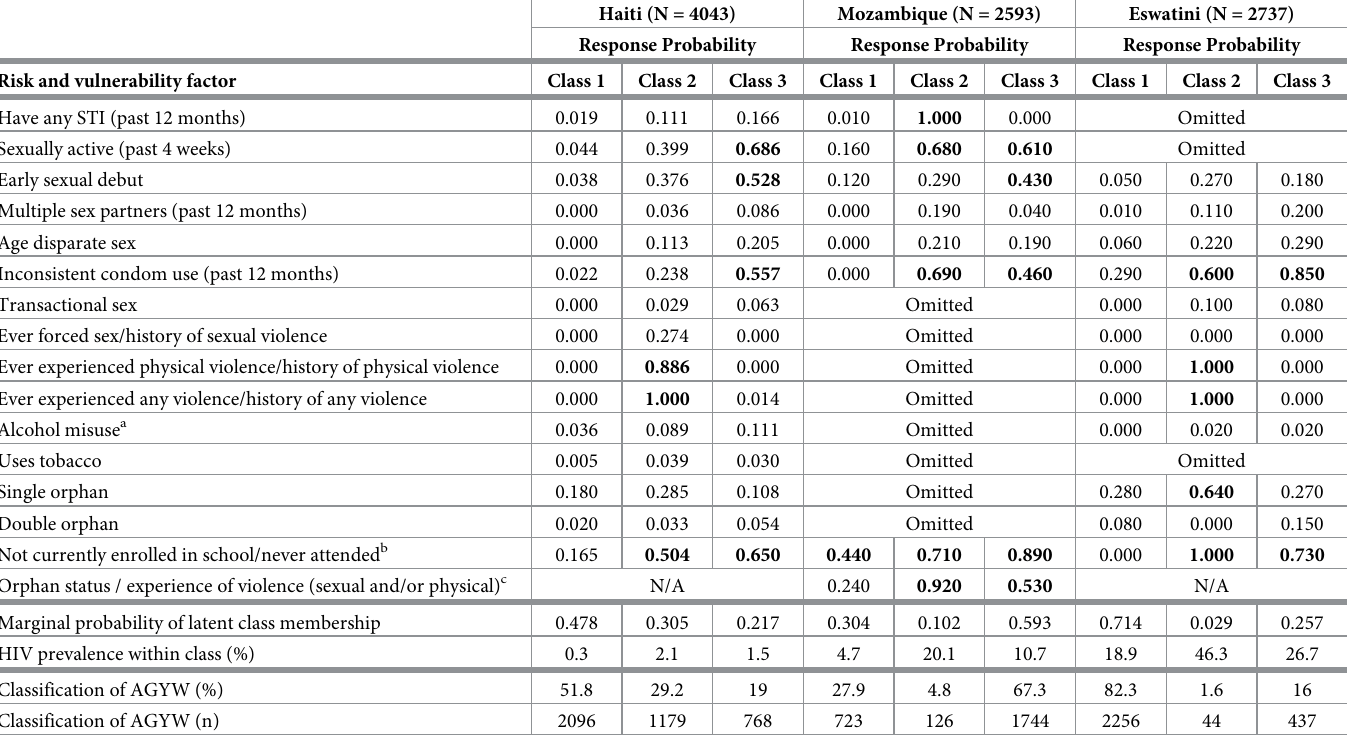
Table 5. LCA conditional response probabilities and membership